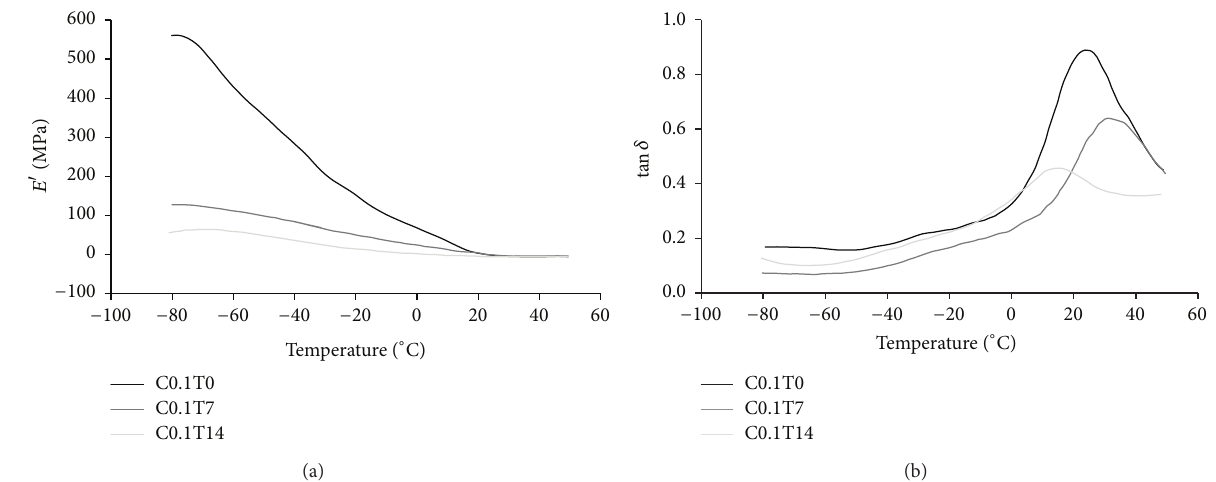
Figure 2: DMTA thermograms. (a) Effect of time on 𝐸 󸀠 of CH/HPMC films modified by cellulase; (b) effect of time on tan 𝛿 of CH/HMPC films modified by cellulose.